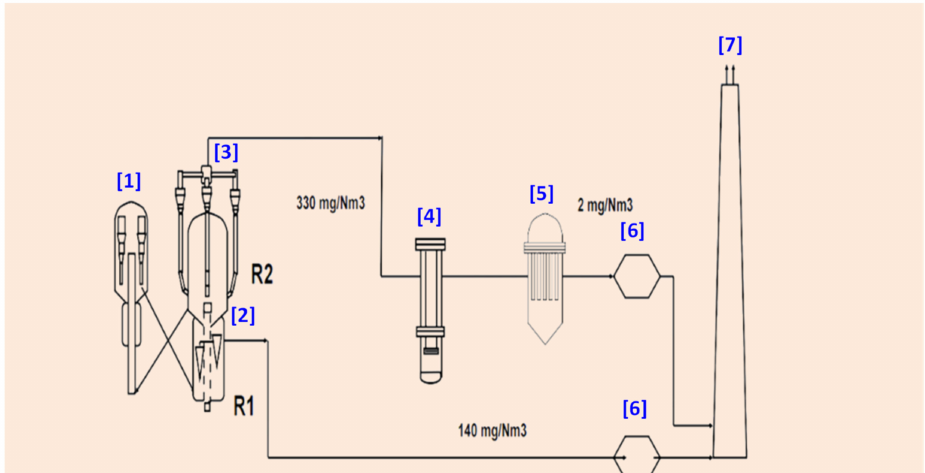
Figure 29. BP Kwinana flue gas particulate removal system. Adopted from Tragesser [45]. (1) Riser; (2) regenerator; (3) third-stage separator; (4) CO boiler; (5) flue gas filter by Pall; (6) orifice chamber; (7) stack.